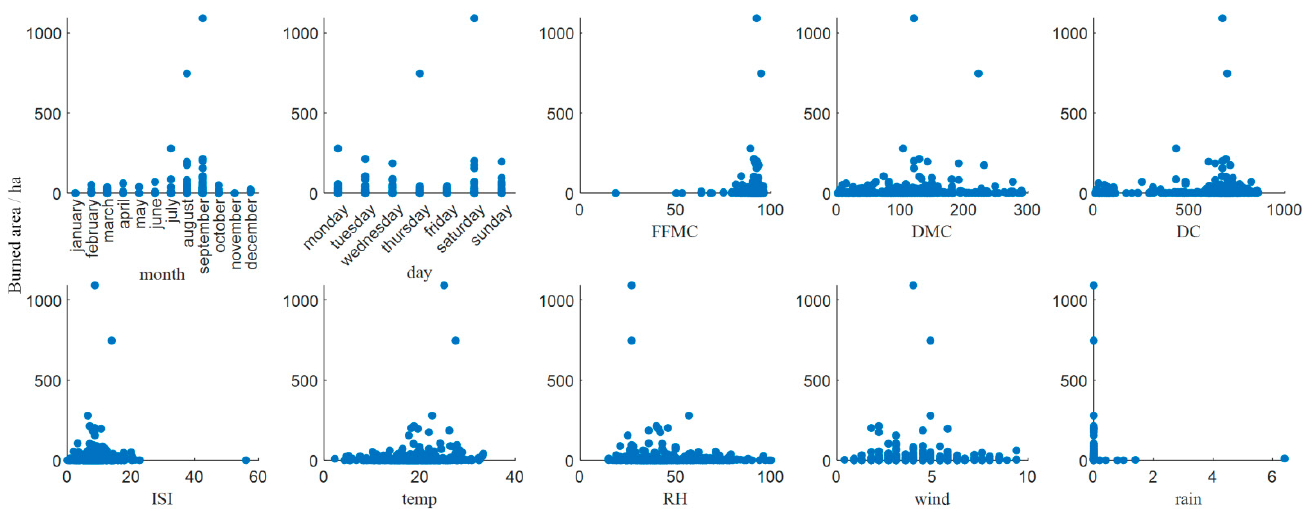
Figure 8. Trends of the burned area and input variables.